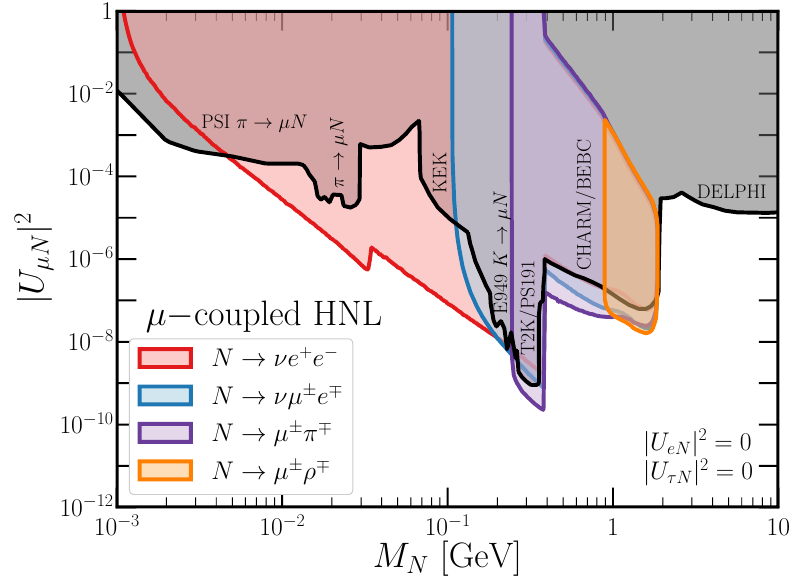
Figure 25 . Expected sensitivity of the DUNE Multi-Purpose Near Detector to a muon-coupled heavy neutral lepton, assuming ten years of data collection (equal time in neutrino and antineutrino modes). We assume that the HNL is a Dirac fermion. Speci(cid:12)c decay channels are considered: N=N (cid:23)e + e (cid:0) (red), N=N (cid:23)(cid:22) (cid:6) e (cid:7) (blue), N=N (cid:22) (cid:6) (cid:25) (cid:7) (purple), and N=N (cid:22) (cid:6) (cid:26) (cid:7) (orange). ! ! ! ! Each channel corresponds to ten signal events, as discussed in section 7.3.1. See text for more detail. to low-mass M N driven by the search for N (cid:23)e + e (cid:0) . We discuss this search channel and ! how an HNL decaying in this way could be diagnosed to be a Dirac or Majorana fermion in section